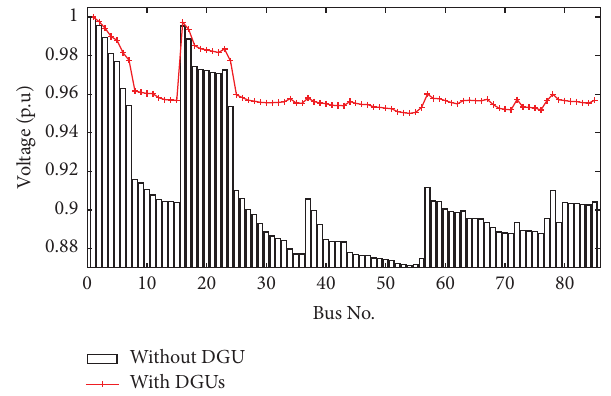
Figure 20: Voltage profle of the IEEE 85-bus system before and after DGUs